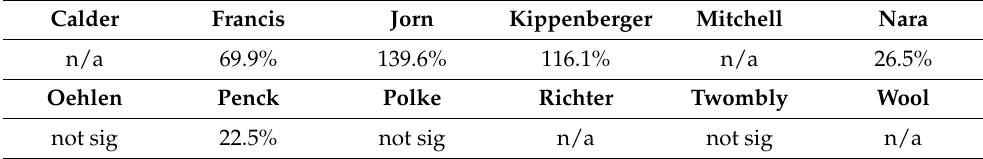
Table 4. Percentage change in price for paintings in oil compared to other media. 12 . Calder Francis